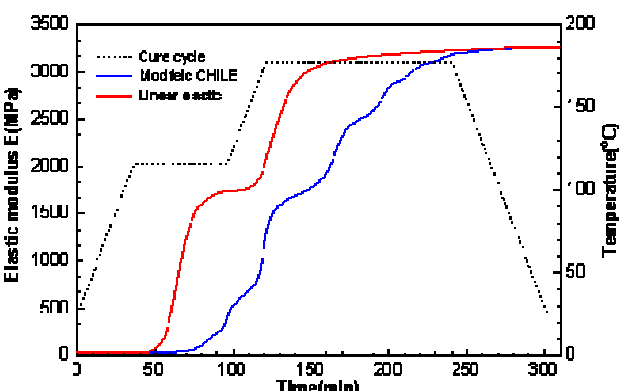
Figure 9. Comparison of elastic modulus in through-thickness orientation in the course of cure cycle from the linear elastic model and the modified CHILE model at constant frequency 0.1 Hz.